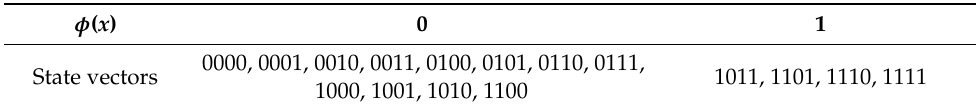
Table 2. Two classes of Binary-State System (BSS) representation. φ ( x